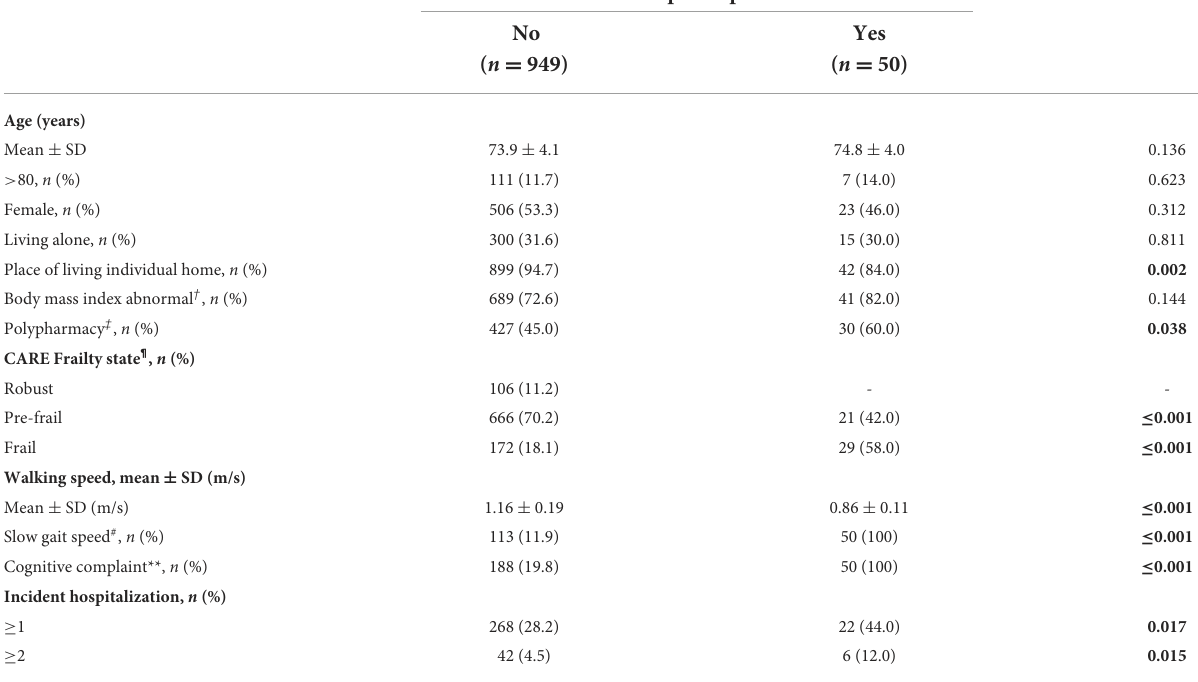
TABLE 1 Baseline characteristics of the NuAge participants stratified by their motoric cognitive risk syndrome status ( n =